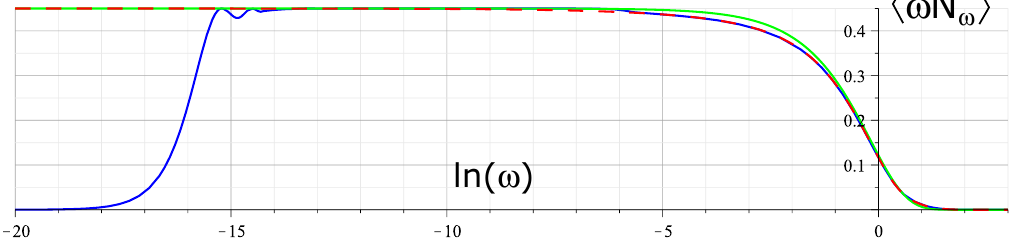
Figure 2 . The Schwarzian effects (right) and level repulsion effects (left) are simultaneously visible in this log plot of h M | ωN ω [ f ] | M i . One may compare the exact answer (blue) with the Schwarzian answer (red) and the semiclassical answer